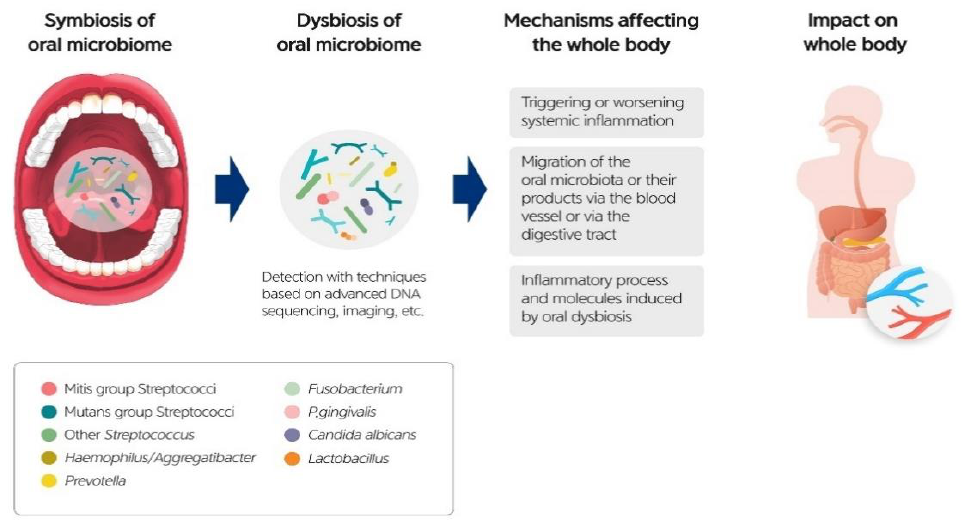
Figure 5. Exacerbation of oral microbial symbiosis to dysbiosis.